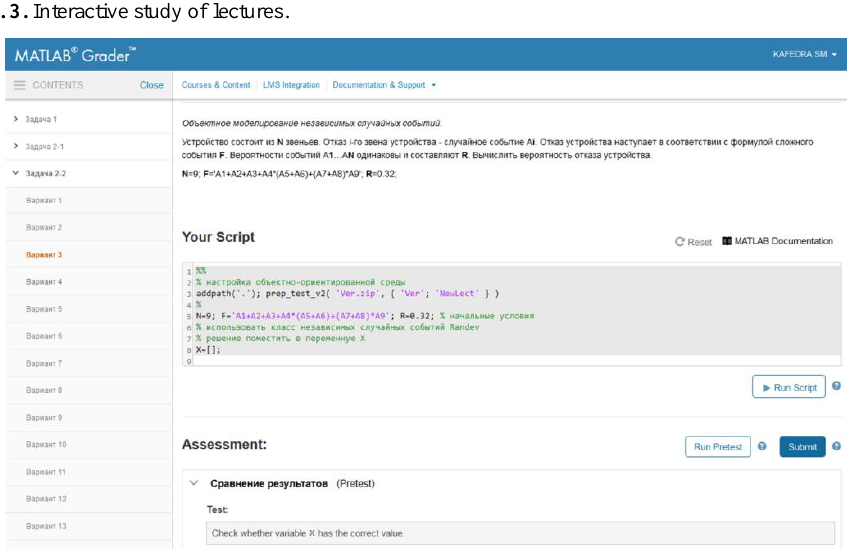
Fig. 4. The example of solving a problem using additional materials in the MATLAB Grader environment.